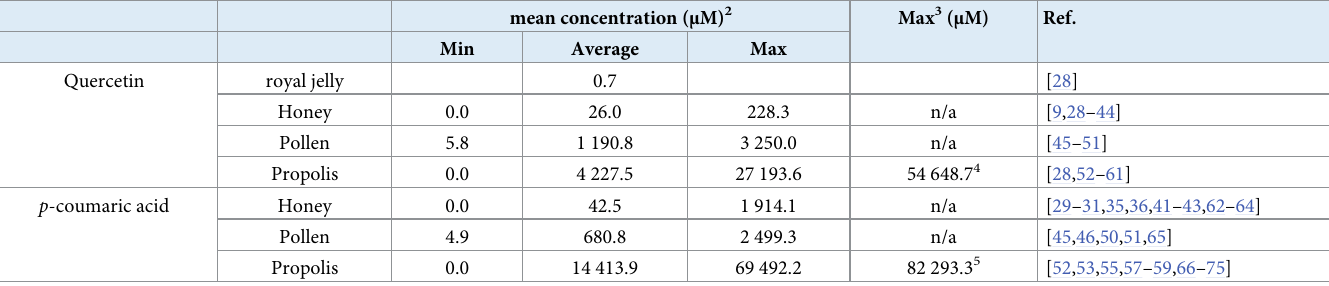
Table 1. Naturally occurring concentrations of quercetin and p -coumaric acid in bee products 1